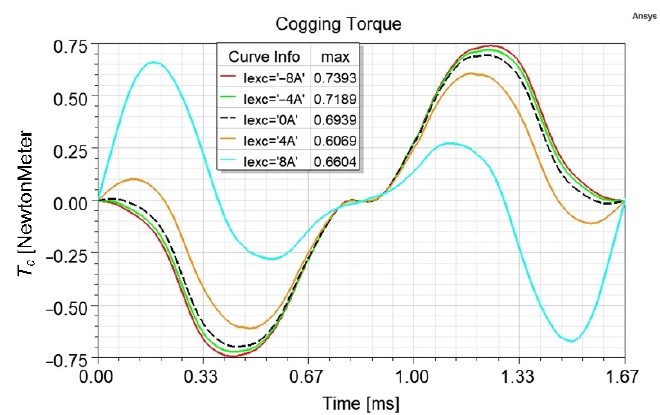
Figure 7. Cogging torque waveforms vs. DC current.